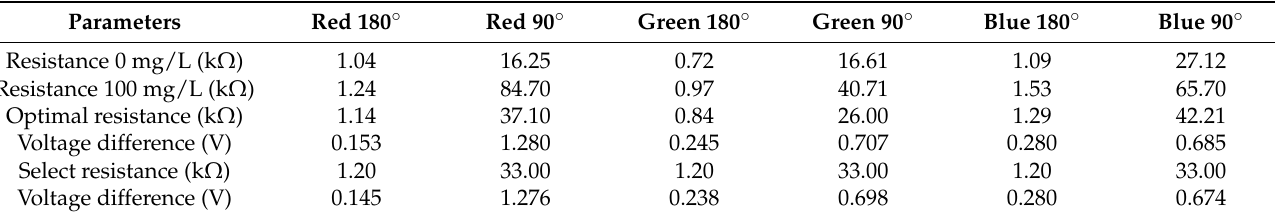
Table 2. Selection of the better resistance in the LDR voltage